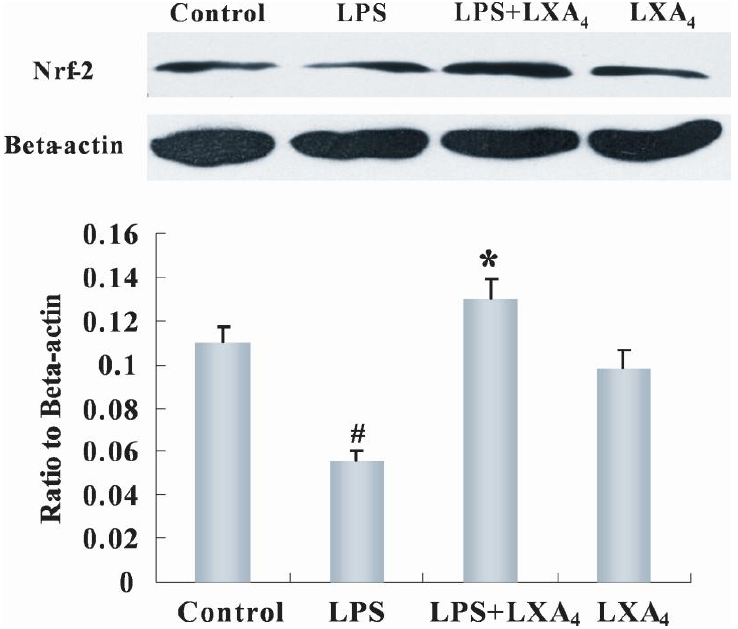
FIGURE 7. Effect of LXA on Nrf-2 protein expression. 4 Representative Western blot for Nrf2 is shown. Bar graphs indicate means ± SEM from at least three independent experiments; # p < 0.05 compared to control cells; * p < 0.05 compared to cells treated by LPS